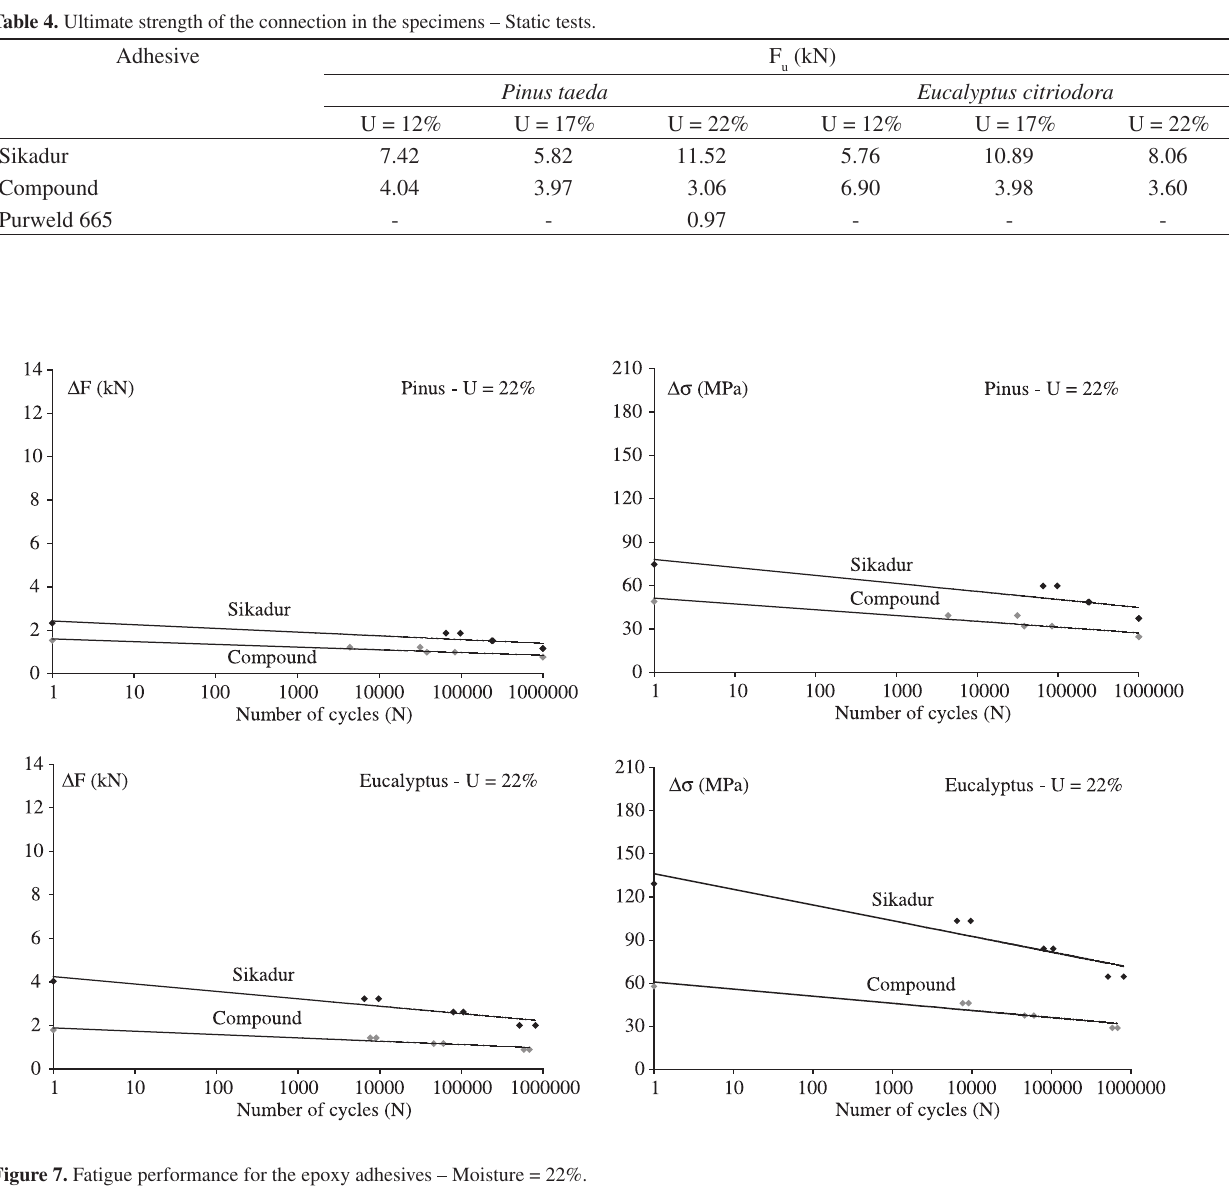
Figure 7. Fatigue performance for the epoxy adhesives – Moisture =